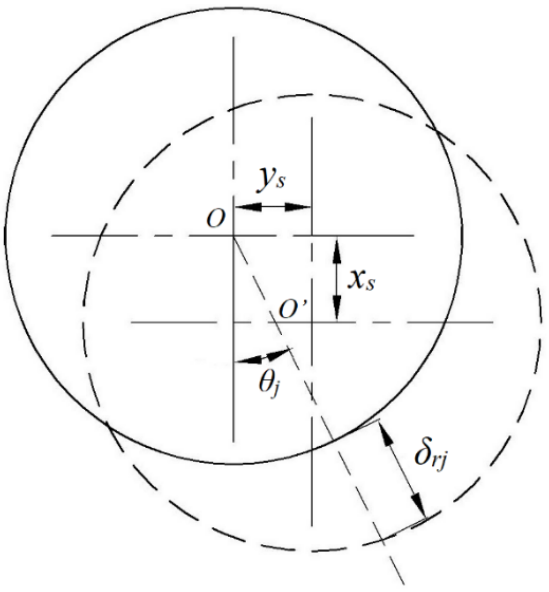
Figure 5. Radial displacement of the inner raceway at the j th ball position.